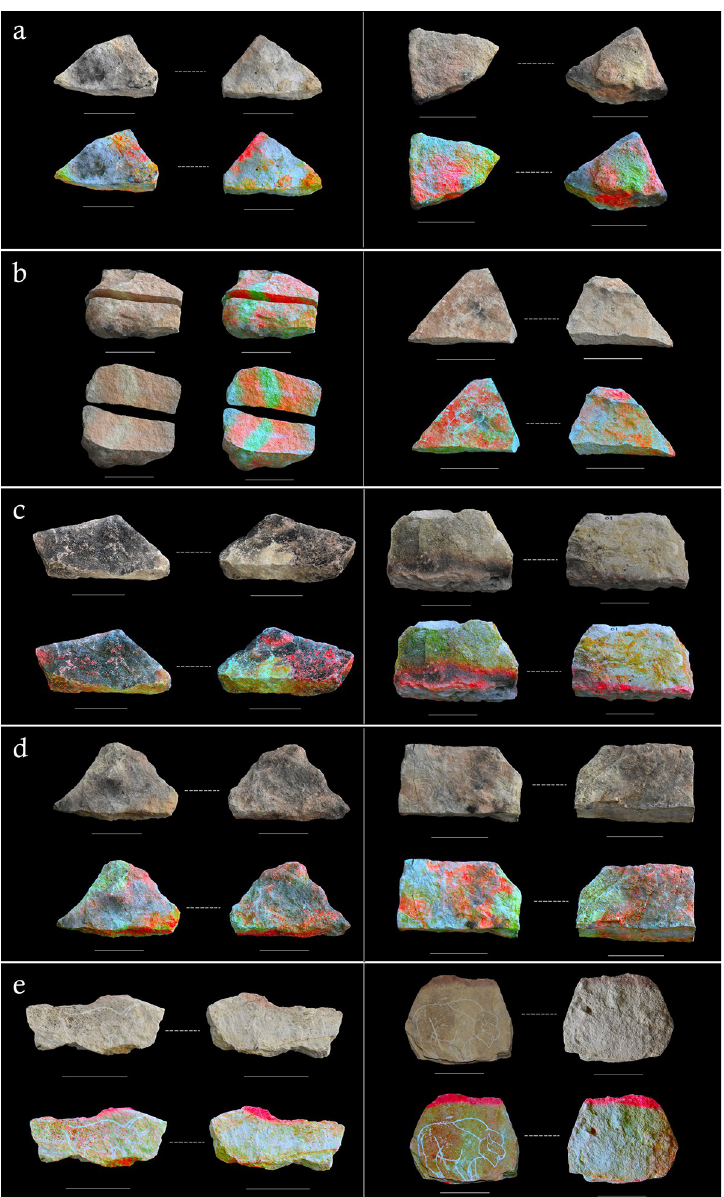
Fig 3. High-resolution photographs and DStretch © images of example replica plaquettes from each experiment. (A) shows plaquettes from the taphonomy experiment that were in direct context with the fire, placed on the surface both uncovered (SU1: left) and covered with sediment (SC1: right). (B) shows replica plaquettes PB3 (left) and PB4 (right) from the boiling stone experiment. (C) shows replica plaquettes A3 (left) and D1 (right) from the hearth oven structure experiment, (D) shows replica plaquettes WP1 (left) and WP3 (right) from the water pour experiment. (E) shows replica plaquettes FS1.1 (left) and FS1.2 (right) from the fireside night experiment. See the S1 File for a full description of the results from each experiment. Scale bar below each replica plaquette is 8cm in